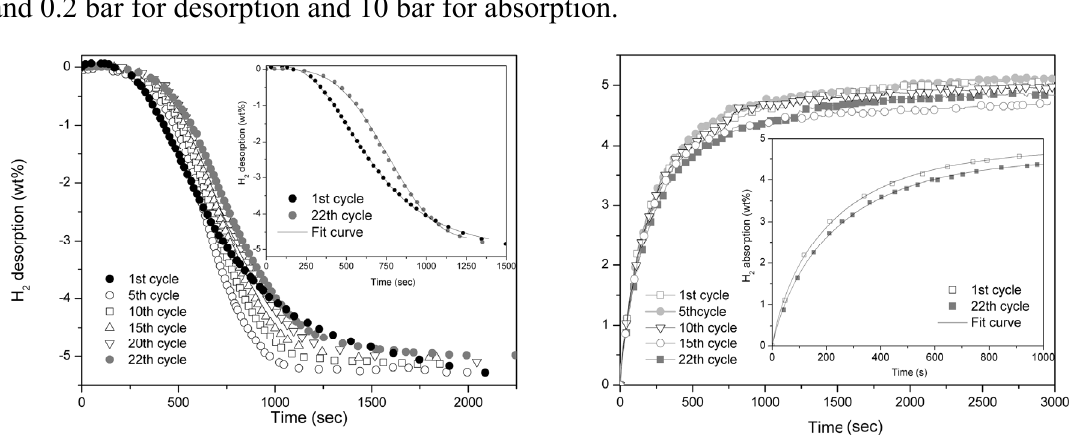
taken at 350 °C 2